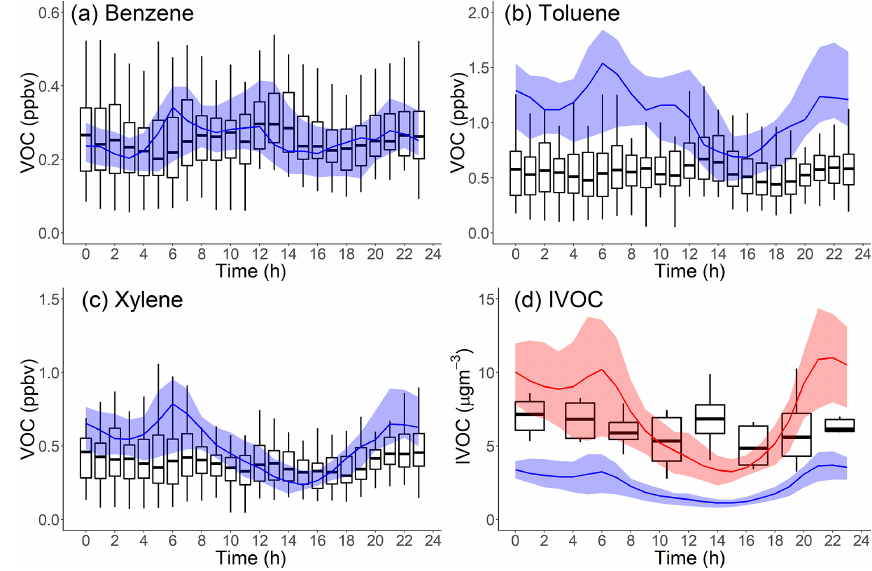
Figure 4. Comparison of measured (boxplot: solid box denotes 25th to 75th percentiles and whiskers denote 10th to 90th percentiles) and modeled (line: shaded area denotes 25th to 75th percentiles) diurnal patterns in Pasadena, CA, during CalNex for the following species: (a) benzene, k OH = 1 . 22 × 10 − 12 cm 3 molec − 1 s − 1 ; (b) toluene, k OH = 5 . 63 × 10 − 12 cm 3 molec − 1 s − 1 ; (c) xylene, k OH = 1 . 36 − 1 . 87 × 10 − 11 cm 3 molec − 1 s − 1 ; and (d) hydrocarbon IVOCs (blue: Case 2, red: Case 3), k OH = 1 . 55 − 7 . 56 × 10 − 11 cm 3 molec − 1 s − 1 .